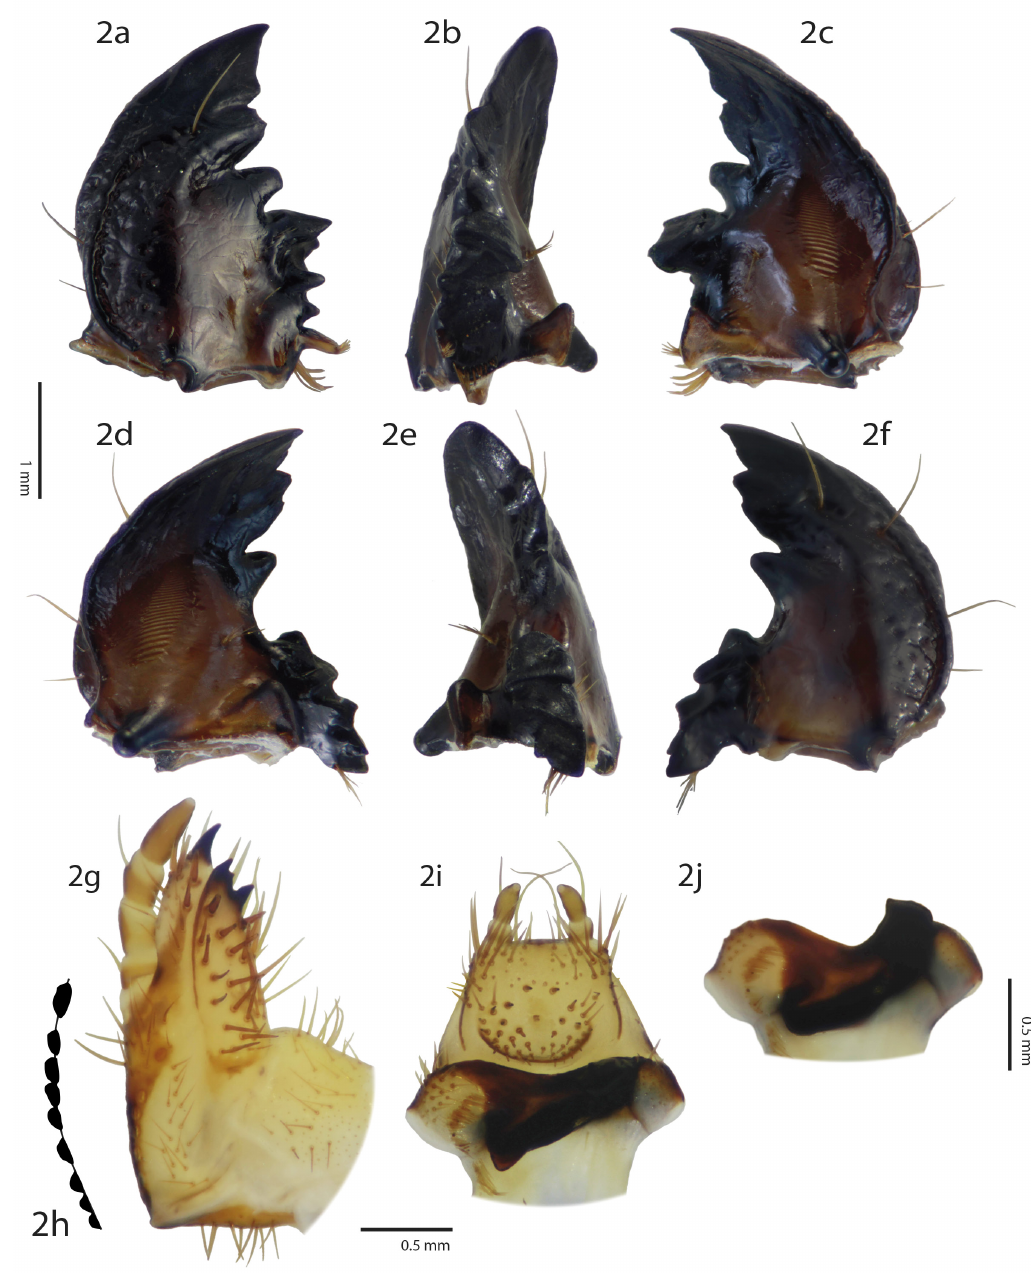
Figure 2. Stenocrates agricola , mouthparts of third instar. (a–j). (a) Left mandible in dorsal view, (b) lateral view, and (c) ventral view. (d) Right mandible in ventral view, (e) lateral view, and (f) dorsal view. (g) Left maxilla in dorsal view and (h) detail of stridulatory teeth. (i) Dorsal view of labium and (j) detail of hypopharyngeal sclerome. setae. Sclerotized plate of right nesium well- slightly defined, with 4 lateral sensilla. Antenna developed, acute at apex, with 8 setae on the (Fig. 1c): Four antennomeres; antennomeres 1–3 base. Sense cone on left nesium represented by and 2–4 subequal in length, antennomere 3 with longitudinal, sclerotized, rounded plate. Crepis a process distally; terminal antennomere